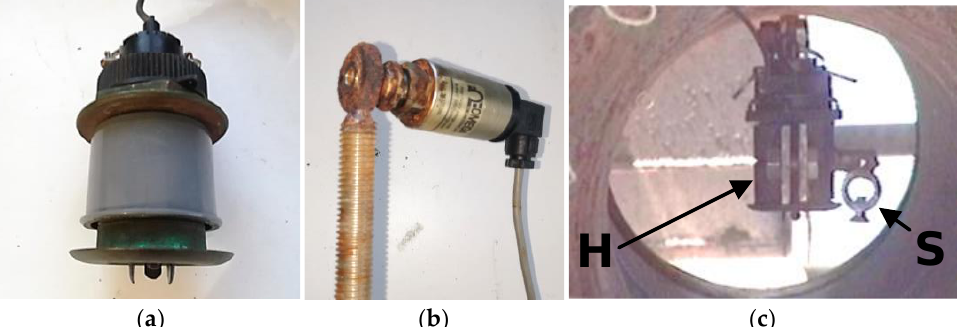
Figure 11. The NAVICO-CORUS TXD300 paddlewheel water velocity transducer used in this study ( a ); the OMEGA PX212-030GV pressure transducer used in this study mounted on the holding rod ( b ); detail of the hanger H holding the water velocity transducer including a sleeve S with a screw to hold and fix the pressure transducer rod, at point P1 ( c ).